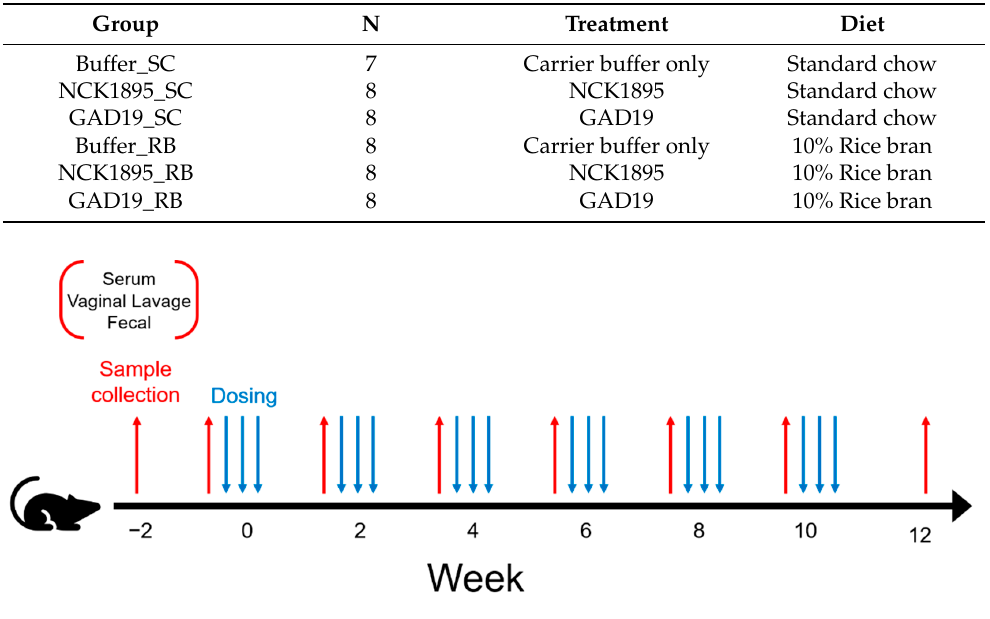
Figure 1. Experimental design for the vaccination schedule. Samples were collected from mice starting immediately prior to the change in diet at week 2. Mice were administered either NCK1895, GAD19, or the dosing buffer alone, as shown in Table 1. Samples collected prior to immunizations every two weeks included serum, vaginal lavage, and fecal